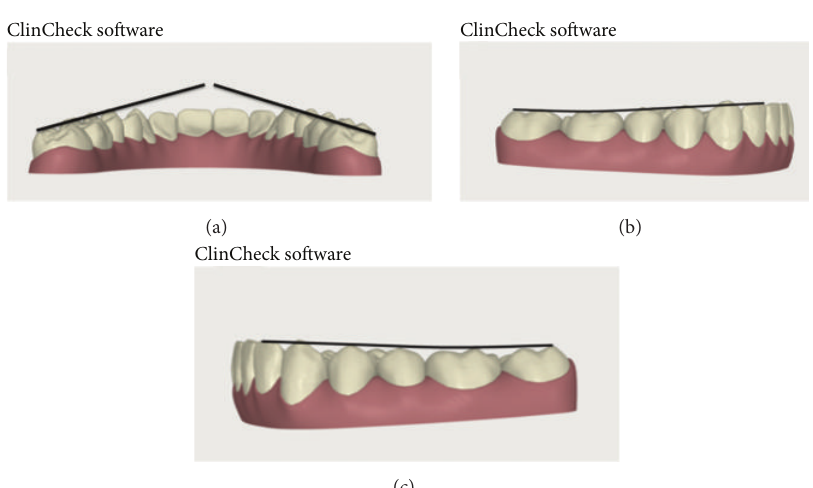
Figure 9: Finishing and detailing phase. (a) Beginning and (b) end of the procedure.